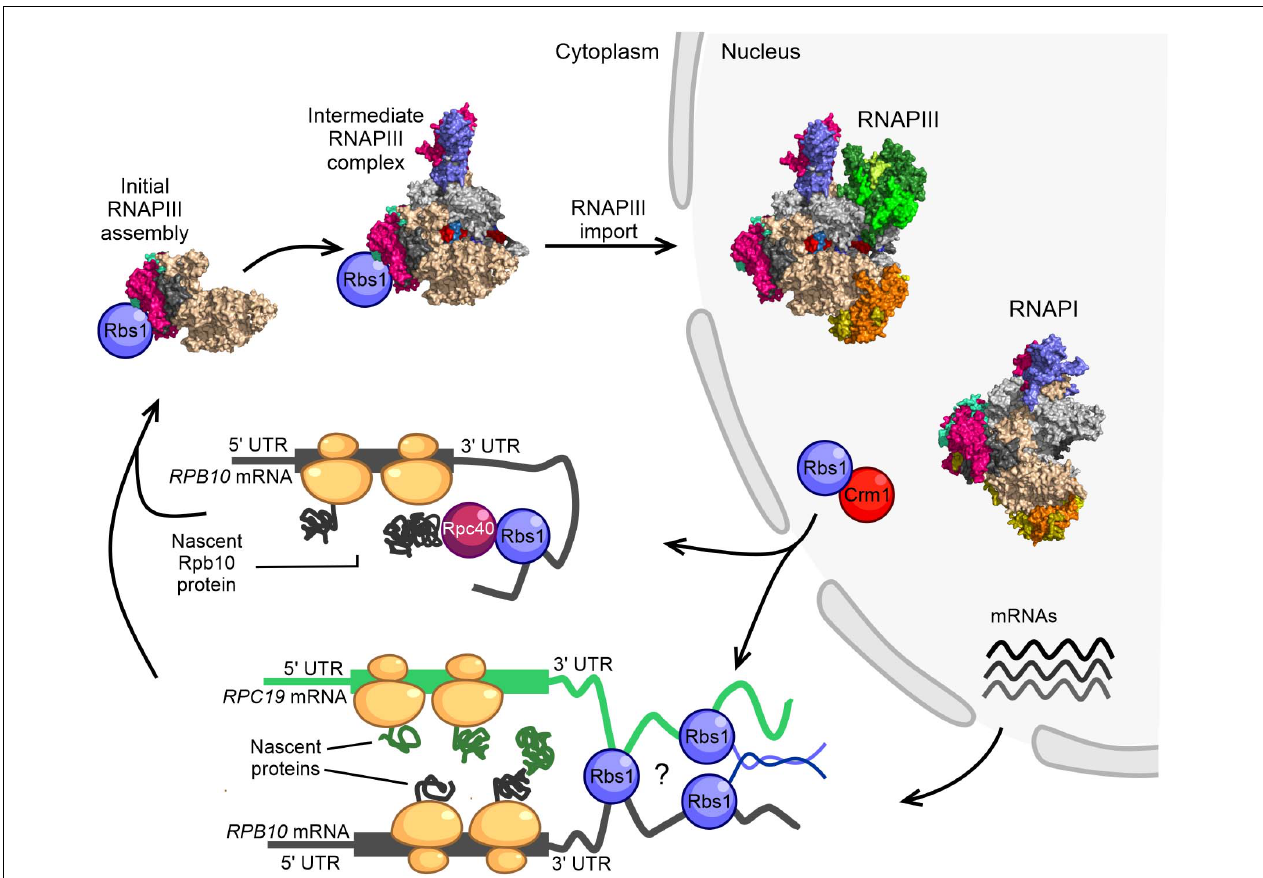
FIGURE 2 | Model of RNAPIII biogenesis in the yeast Saccharomyces cerevisiae . The control of Rpb10 expression and role of Rpb10 in assembly of the RNAP III complex are connected via a regulatory loop that involves Rbs1 protein. Possible ways in which subunits of the RNAPIII intermediate complex are brought together for co-translational assembly are shown. The initial step of RNAPIII assembly in Saccharomyces cerevisiae occurs in the cytoplasm. Formation of the intermediate Rpc128-Rpc40-Rpc19-Rpb12-Rpb10 subcomplex is seeded co-translationally while the Rpb10 subunit is being synthesized by cytoplasmic ribosomes. Rbs1 is an RNA binding protein that stimulates the translation of Rpb10 protein through an interaction of the R3H domain with the 3 (cid:48) -UTR in RPB10 mRNA. Rpb10 brings together the Rpc19 and Rpc40 subunits to form the α -like heterodimer. One possibility is that Rbs1 binds and recruits the mature Rpc40 subunit to the 3 (cid:48) -UTR of RPB10 mRNA, which undergoes translation. The Rpc40-Rbs1 interaction has been previously demonstrated by co-immunoprecipitation. Alternatively, Rbs1 protein directly bridges RPB10 mRNA and RPC19 mRNA. A fully folded subunit that formed on one mRNA was recently shown to detach from its ribosome and interact with a nascent protein on another mRNA (Cie´sla et al., 2015,